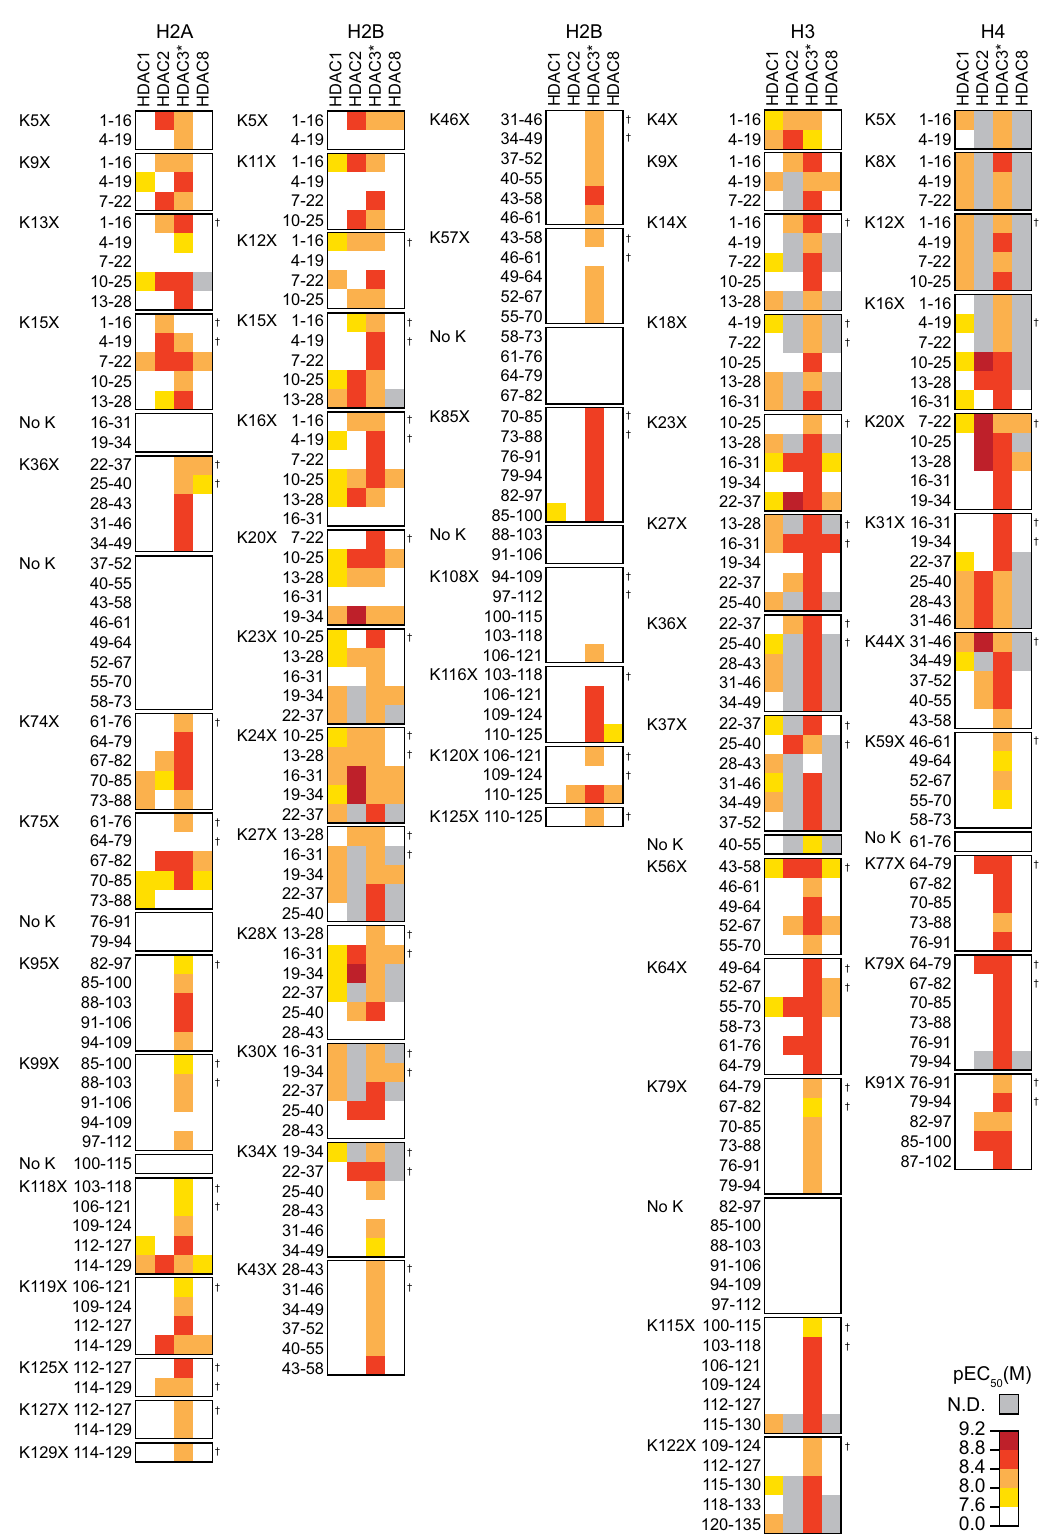
Fig. 3 Screening of class I HDAC ‒ histone peptide binding in microarray format. Heat map representation of relative HDAC binding af fi nity for Asuha (X)- containing histone peptides. The pEC 50 values represent the concentration of HDAC enzyme required for half-maximal binding signal ( n = 4 independent dose- response experiments). White squares represent weak binders (pEC 50 <7.6). N.D. = not determined (non-sigmoidal data). Source data are provided as a Source Data fi le. *HDAC3 tested in combination with the deacetylase activating domain (DAD) of NCoR2. † Matrix steric effects might impede protein binding to these